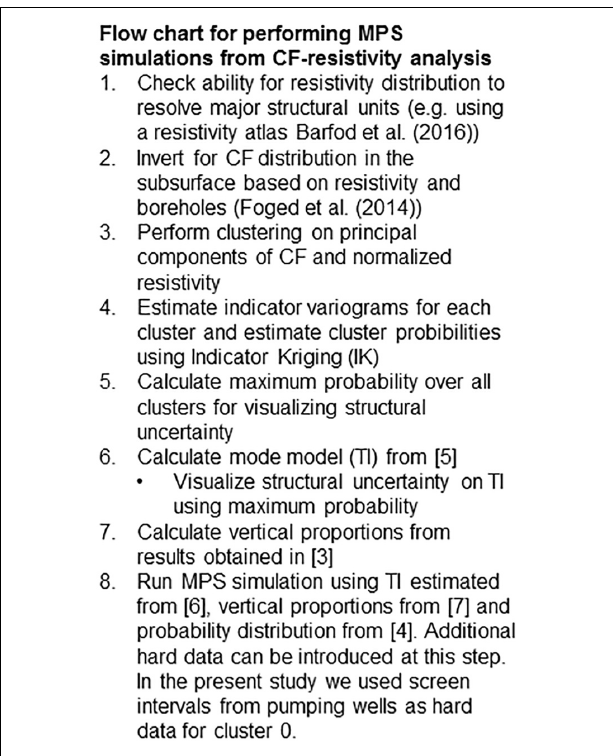
FIGURE 2 | Outline for generating structural realizations based on